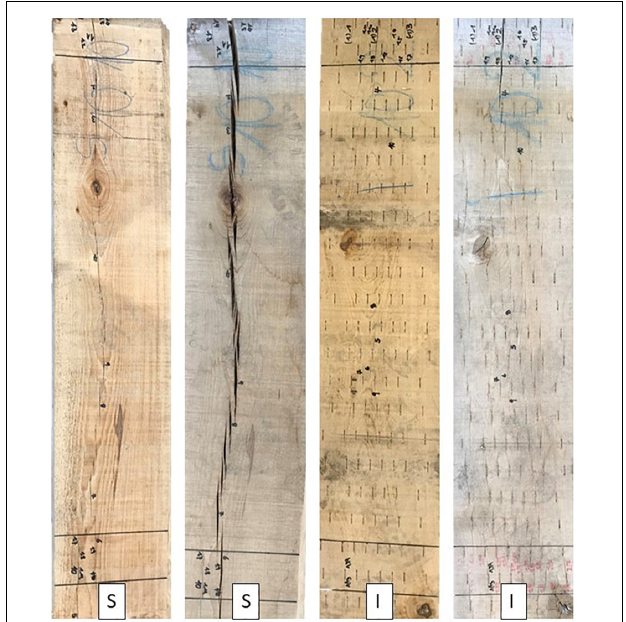
FIGURE 6 | Examples of positively influenced check performance due to incising of Beech sleepers [ n = 5 for both incised (I) and not incised sleepers (S)] between 13.02.2018 (left) and 07.11.2018 (right) .